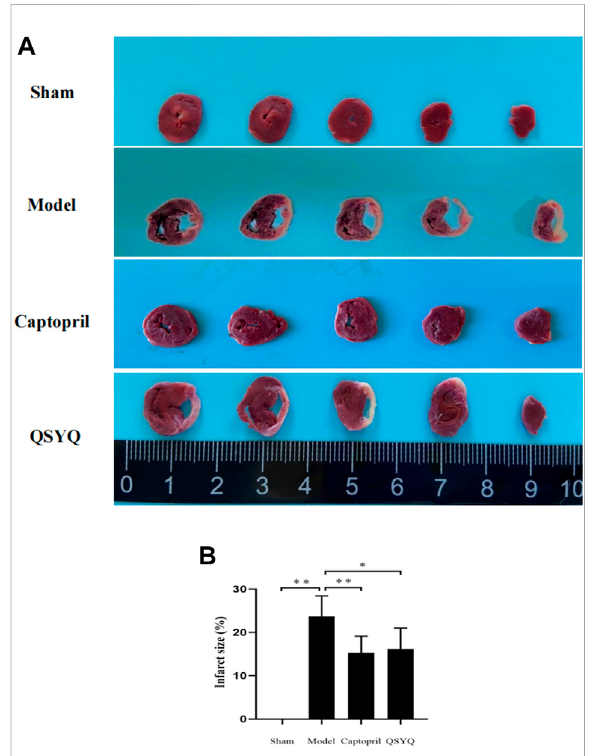
FIGURE 7 Effect of QSYQ on myocardial infarct size. (A) : TTC staining showed: in sham group, the myocardial tissues were with regular shape and ventricular enlargement was not observed. The model group showed morphological changes of myocardium, with the characteristic of left ventricular enlargement, and infarct ventricle walls turning thin and pale. The infarct size signi fi cantly increased in model group. Compared with the model group, the infarct size signi fi cantly decreased in both the captopril and QSYQ groups. (B) : quantitative analysis of QSYQ on myocardial infarct size, n = 4 per group. Data are expressed as mean ± SD. * p < 0.05, ** p <